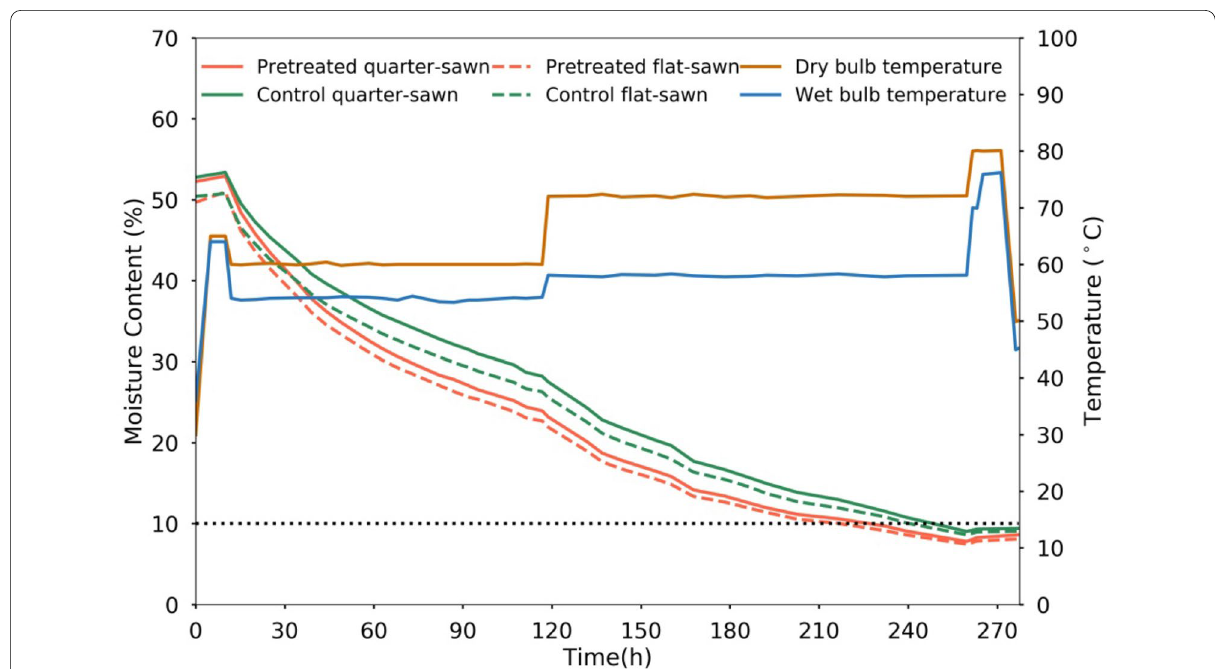
Table 2 Drying rate of MW-pretreated and control samples in different drying stages Sample Table 3 MC and residual stress index of MW-pretreated and control samples after drying Sample Final MC (%) Drying uniformity (%) MC deviation in the thickness Pretreated quarter-sawn Control